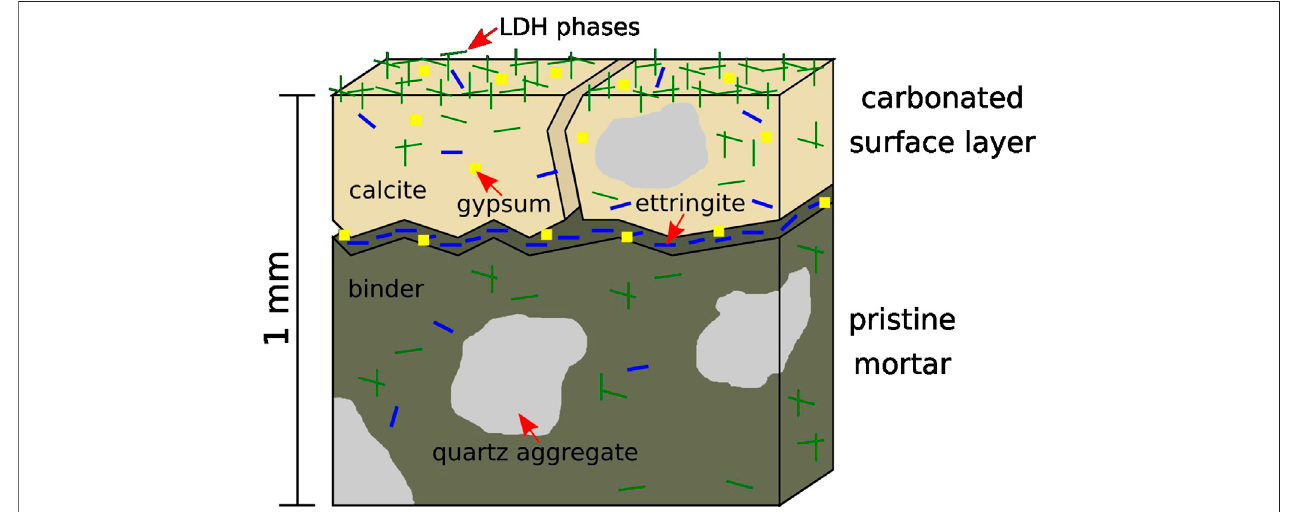
FIGURE 4 | Simpli fi ed scheme (cross section) of the outer 1 mm of a mortar based on a GGBS-rich binder after storage in a sodium sulfate solution for several months. A carbonated surface layer incorporating sulfate attack products and high concentration of LDH phases is formed.